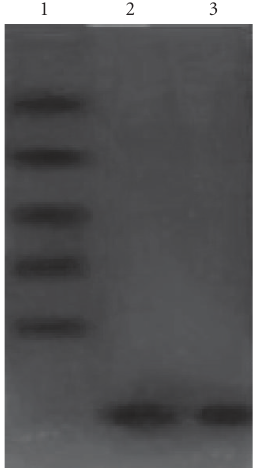
Figure 5: Analysis of hydroxylamine cleavage products. Lane 1: peak 1 of G-25 column chromatography revealed the protein with a molecular weight of more than 5kD that was eluted early. Lane 2: peak 2 of G-25 column chromatography containing the protein with a molecular weight of less than 5kD that was eluted later. Lane 3: the T α 1 synthesized as a standard